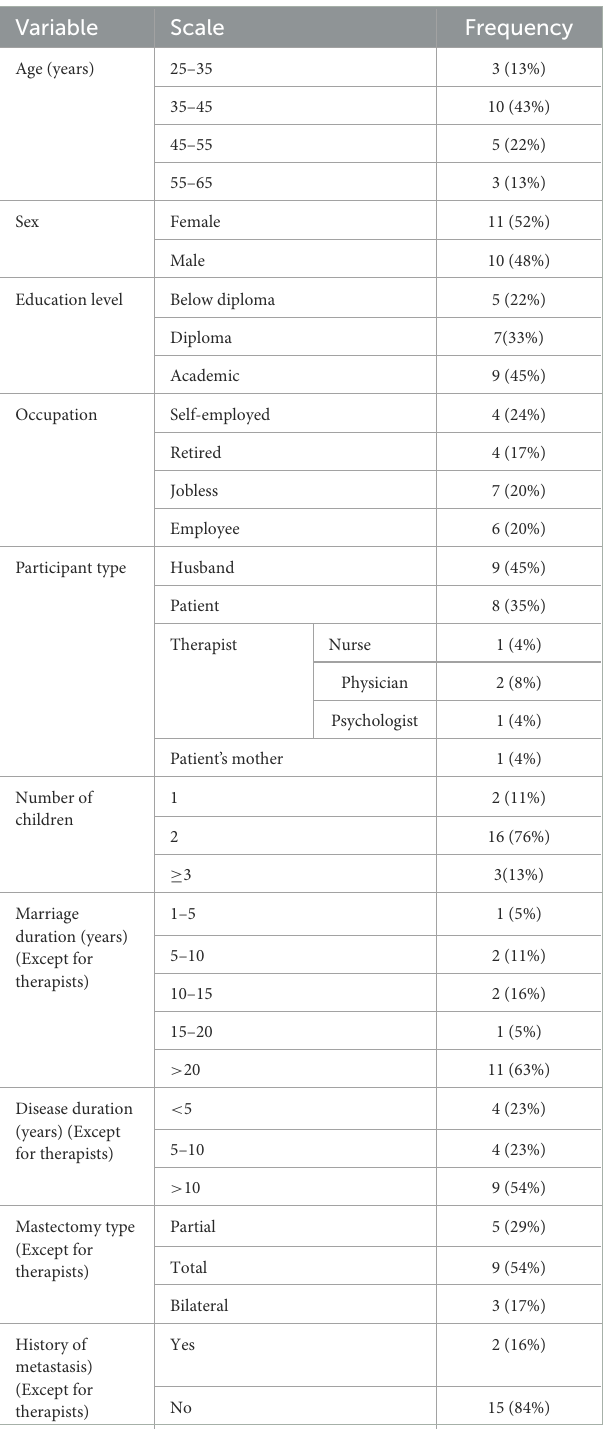
TABLE 1 The participants’ demographic features and underlying